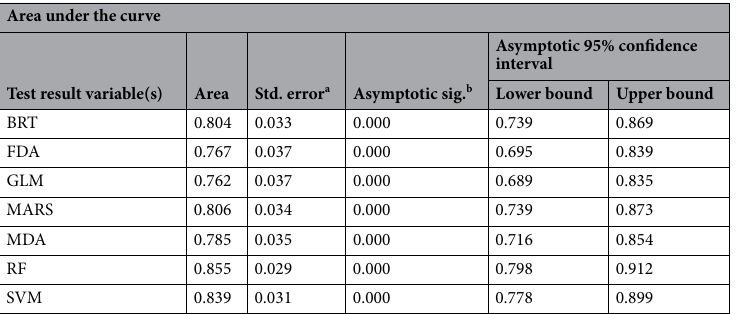
Area under the curve